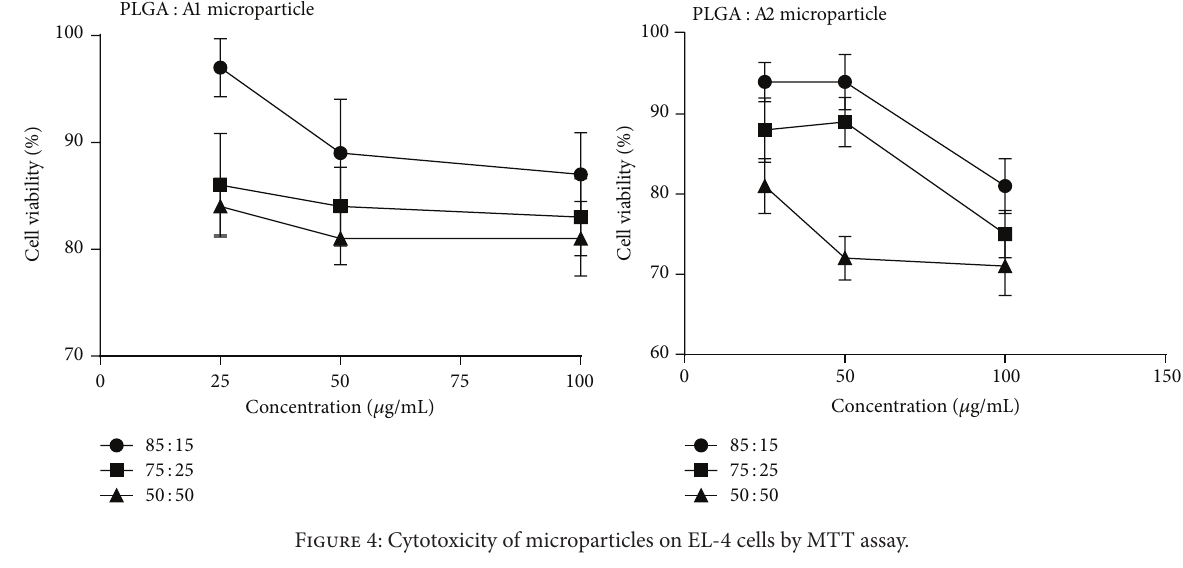
Figure 4: Cytotoxicity of microparticles on EL-4 cells by MTT assay.